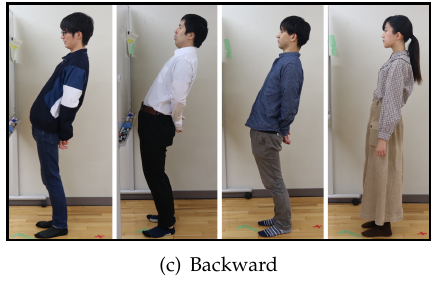
Figure 4. Participants’ motion.